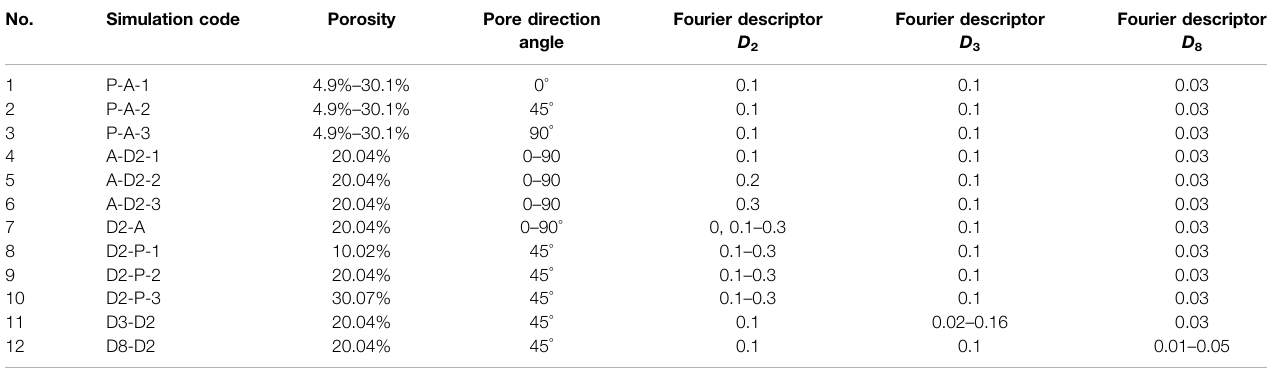
TABLE 3 | The uniaxial compressive simulation projects.